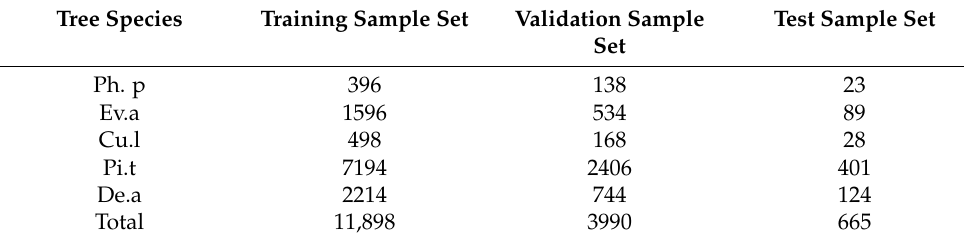
Table 2. The remote sensing sample set of ITSs. Table 3. The enhanced sample set of